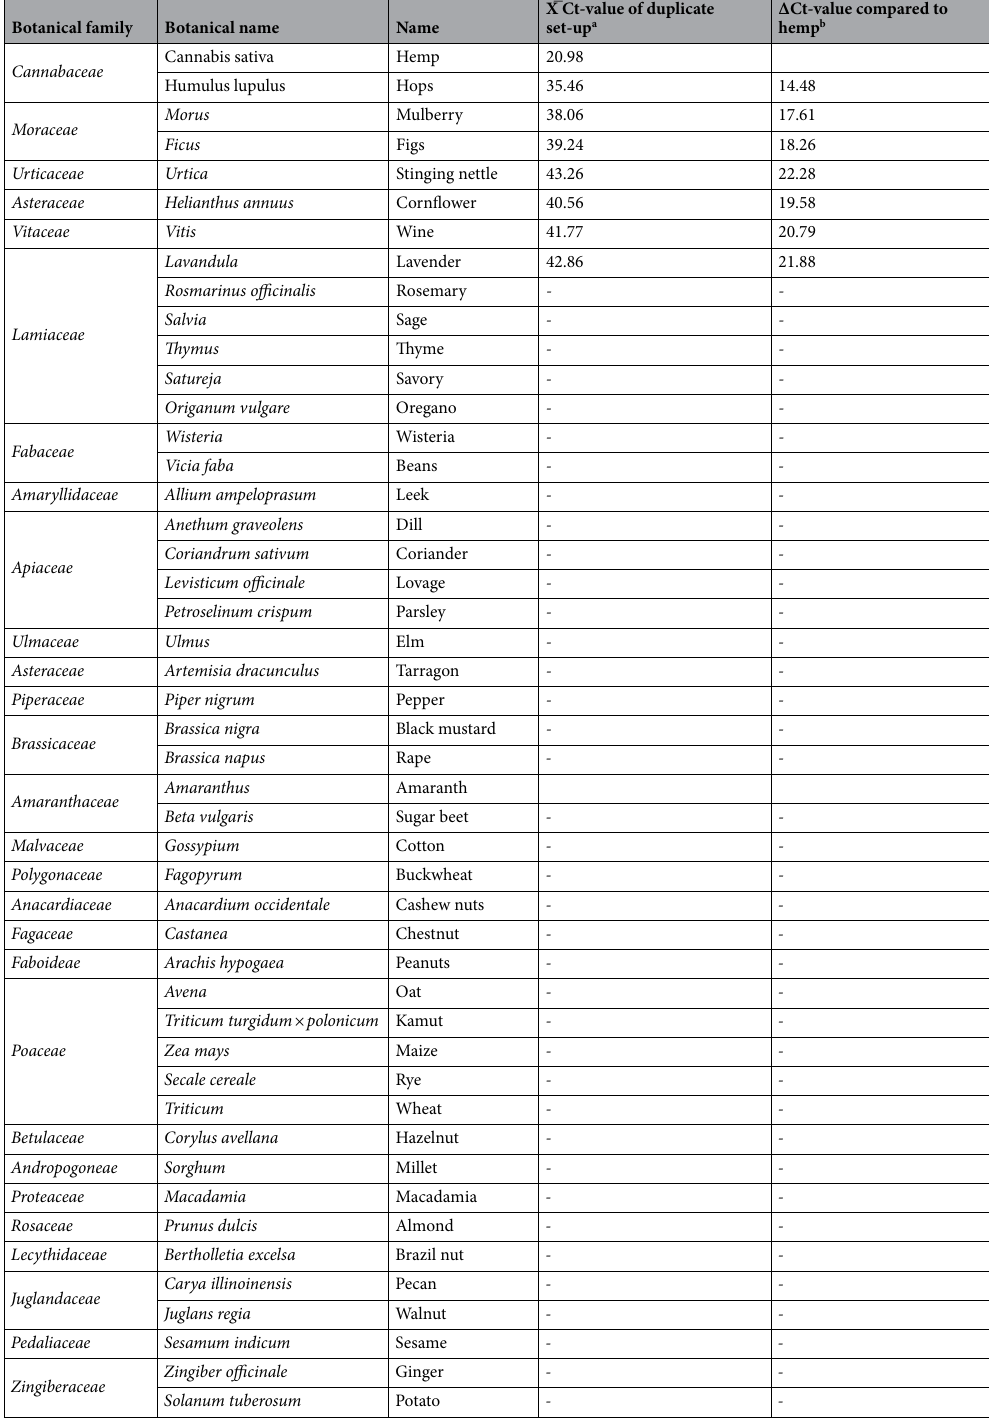
Table 3. Results of cross reactivity tests, obtained with 5 ng/µl DNA per tube. - No increase of the